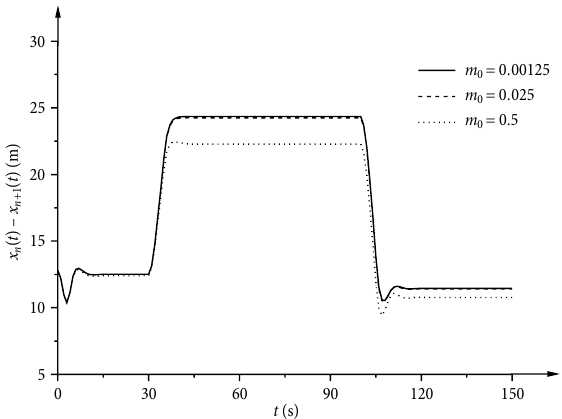
Fig. 8. A comparison between the follower’s sensitivity to the speed difference between the two vehicles and that to the leader’s acceleration, based on the settings in Ex. 7